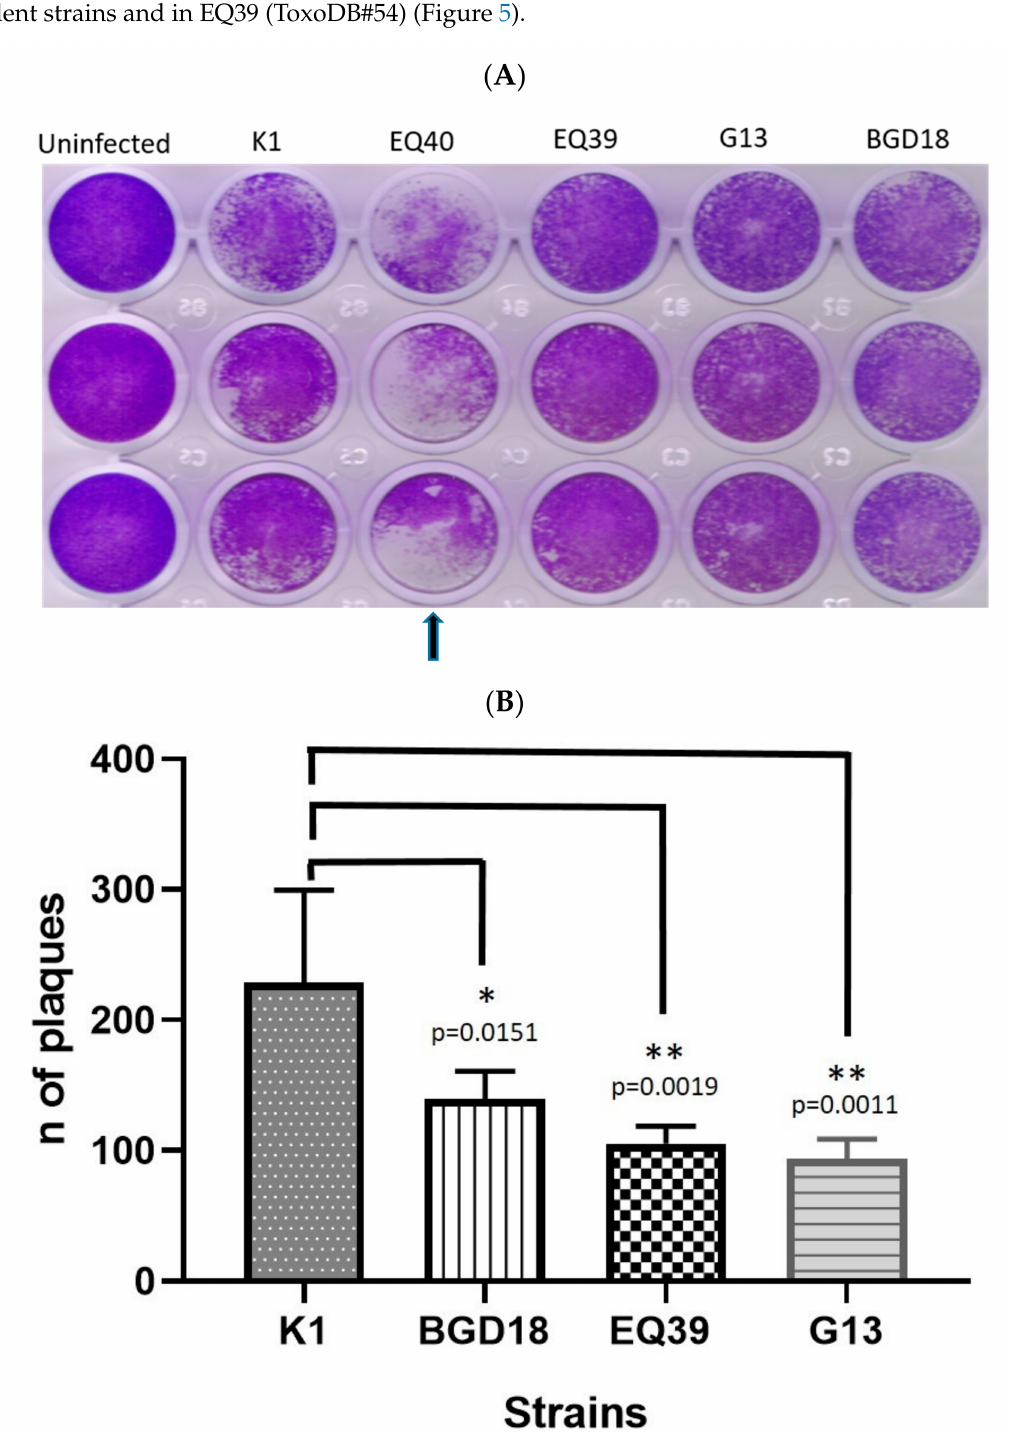
Figure 4. Ten day plaque assay results: ( A ) images of three replicates per strain (arrow: individual plaques formed by EQ40 were no longer distinguishable after fusion); ( B ) mean number of plaques (* p < 0.05; ** p < 0.01; average ± SEM: K1 228.5 ± 29.05; BGD18 (ToxoDB#1) 139.8 ± 8.6; EQ39 (ToxoDB#54) 105.5 ± 5.47; G13 93.6 ±